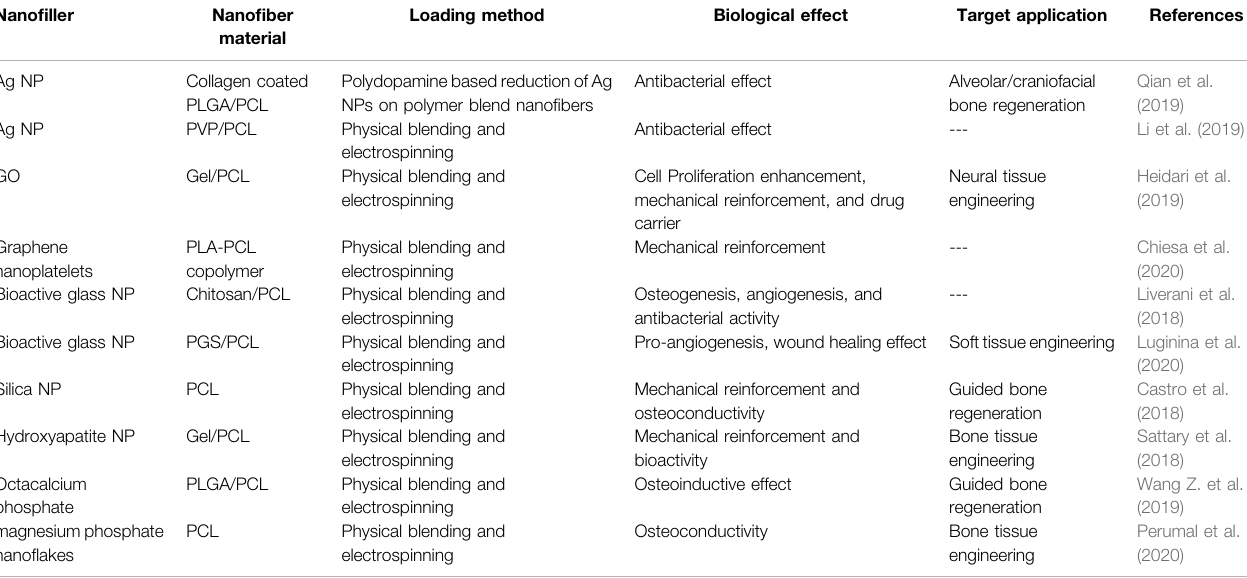
TABLE 6 | Inorganic and carbon nano fi llers of PCL nano fi bers for biomedical applications (the studies carried out since 2017 have been taken into